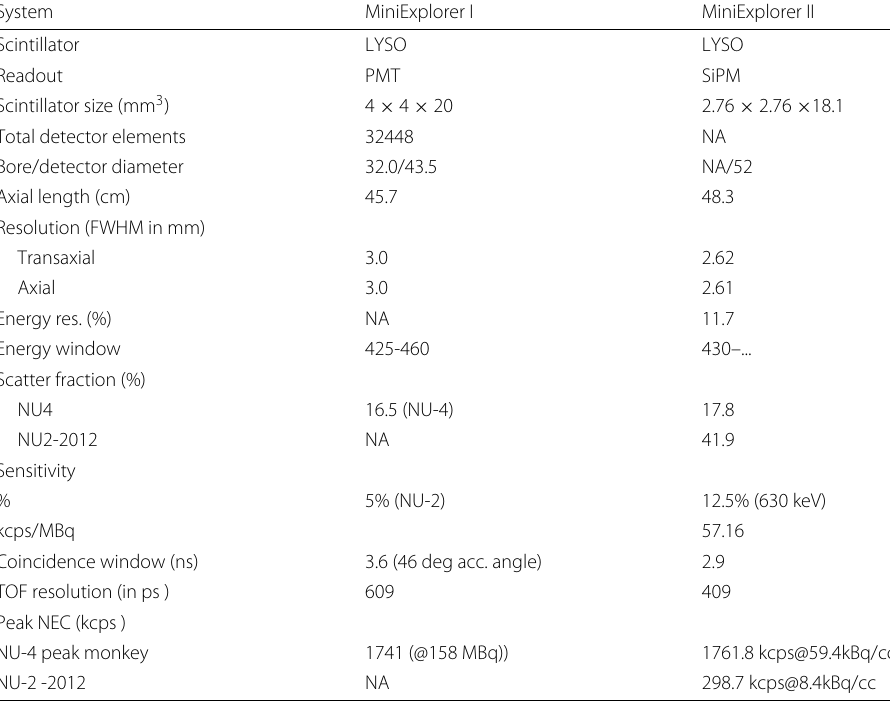
Table 1 Specifications of the developed total Body PET systems for animal (or human brain) use in the Explorer project System MiniExplorer